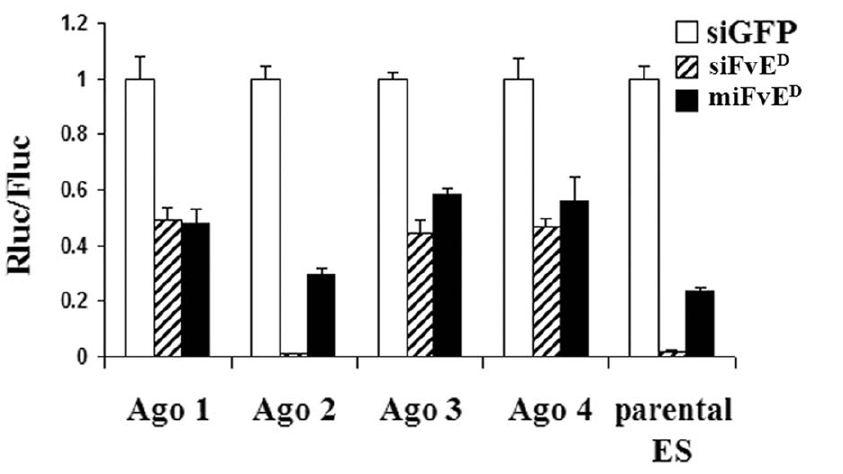
Figure 1. All 4 Ago proteins bind both fully complementary siRNA and partially complementary miRNA resembling oligos and repress target gene in reporter assays. Parental ES cells expressing all ago proteins and ES cells expressing individual Ago proteins were transfected with dual luciferase reporter vector containing dengue virus siRNA target sequences in the Renilla luciferase 3 9 UTR along with fully or partially complementary dengue virus siRNAs and the dual luciferase expression measured after 24 h of transfection. Rluc/Fluc expression normalized to control irrelevant GFP siRNA is shown. Error bars represent mean of quadruplicates + / 2 SD.